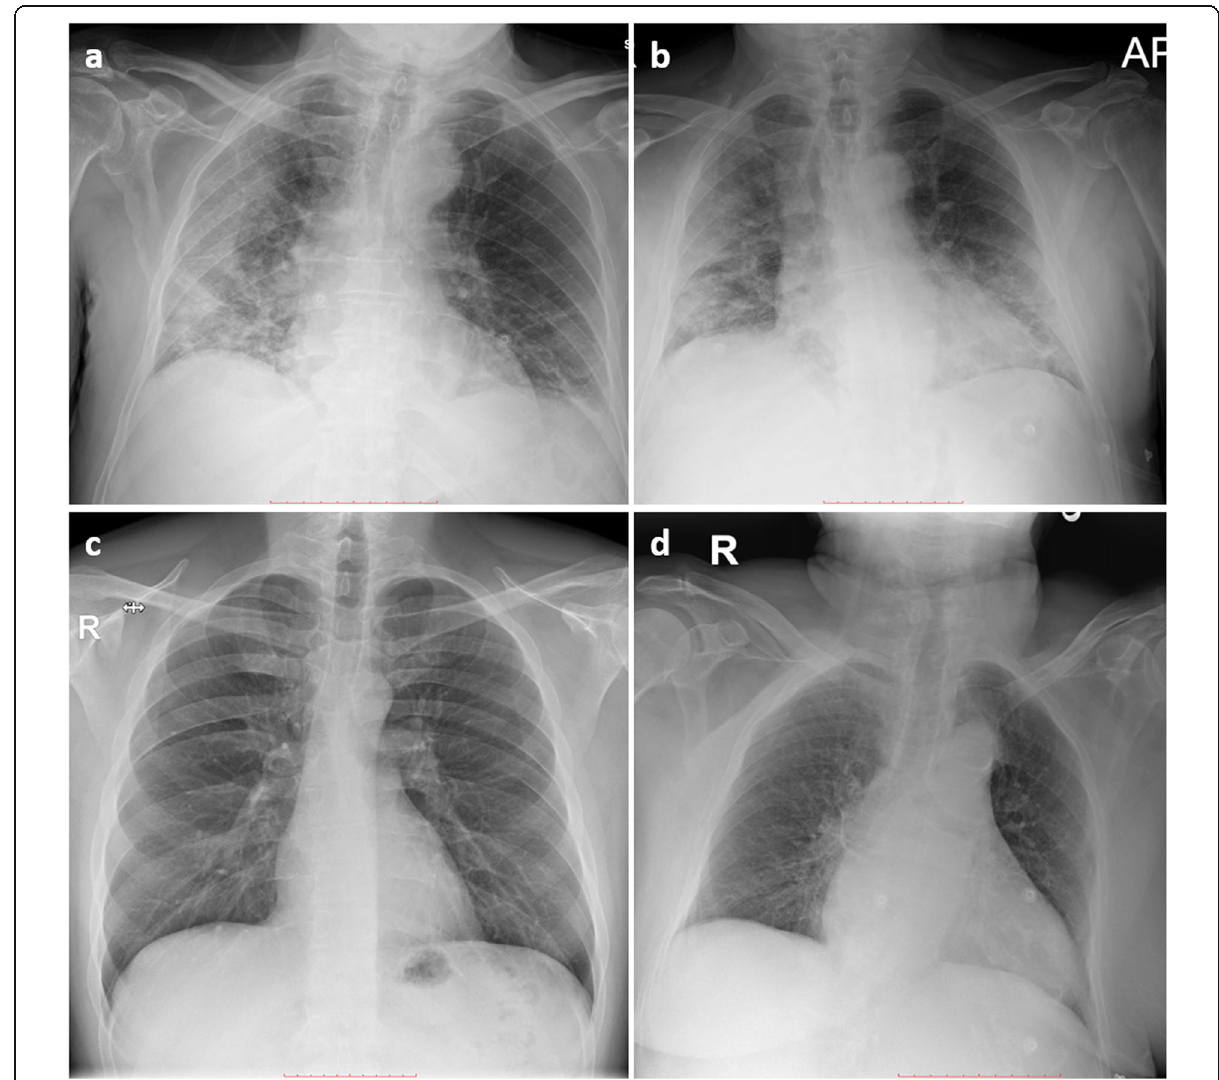
Fig. 3 Sample chest x-ray examinations from patients included in the study sample. Posteroanterior projection in a COVID-19-positive 75-year-old male patient ( a ), bedside anteroposterior projection in a COVID-19-positive male patient ( b ), posteroanterior projection in a negative 42-year-old male patient ( c ) and bedside anteroposterior projection in a negative 88-year-old female patient ( d